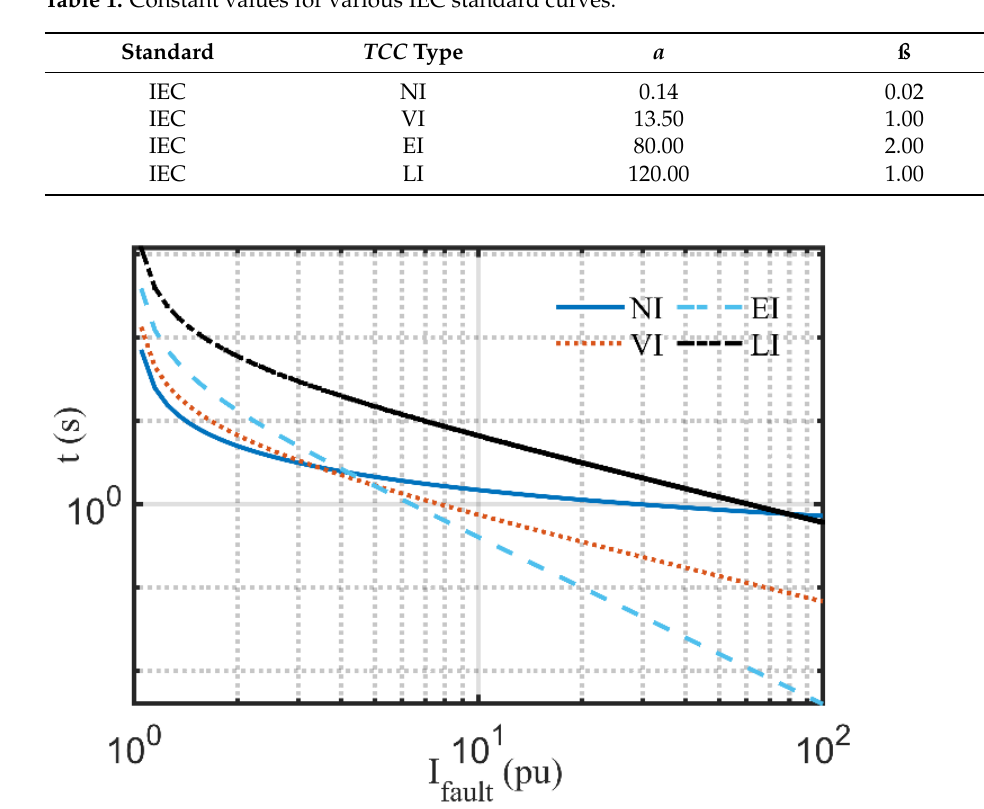
Figure 1. A log-to-log plot for IEC 60255-3